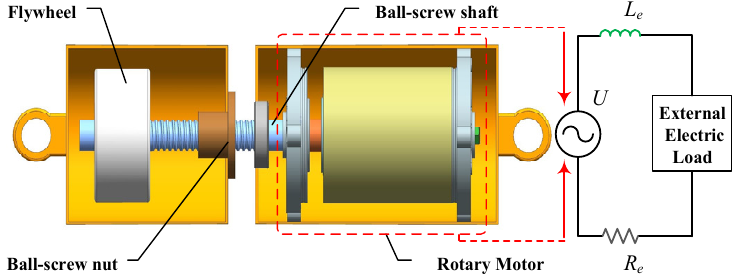
Figure 1. The schematic of ball-screw mechatronic inerter.